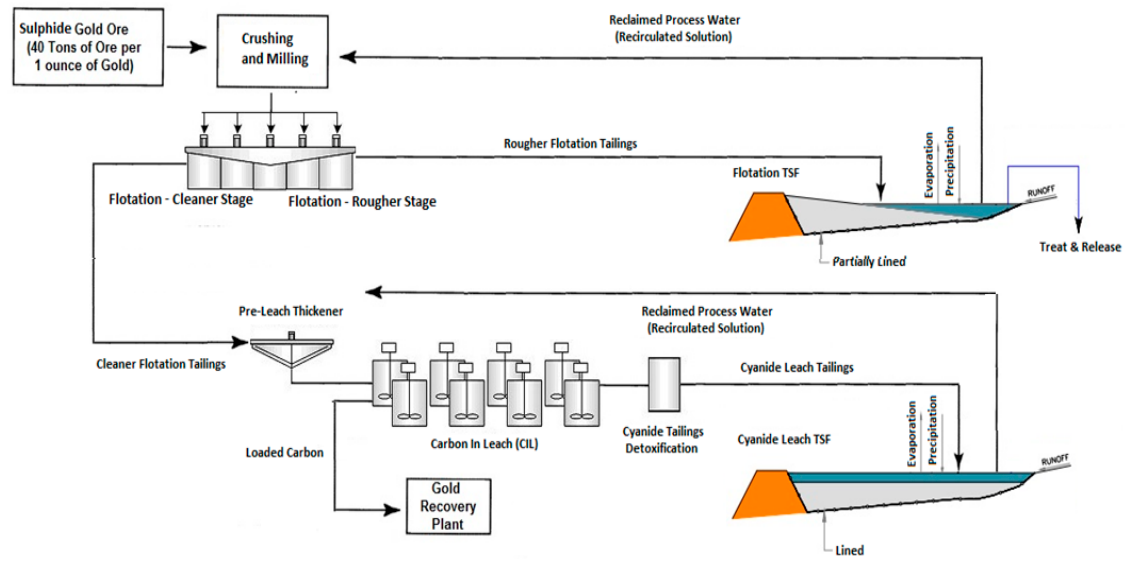
Figure 1. Typical Gold Ore Sulphide Process.